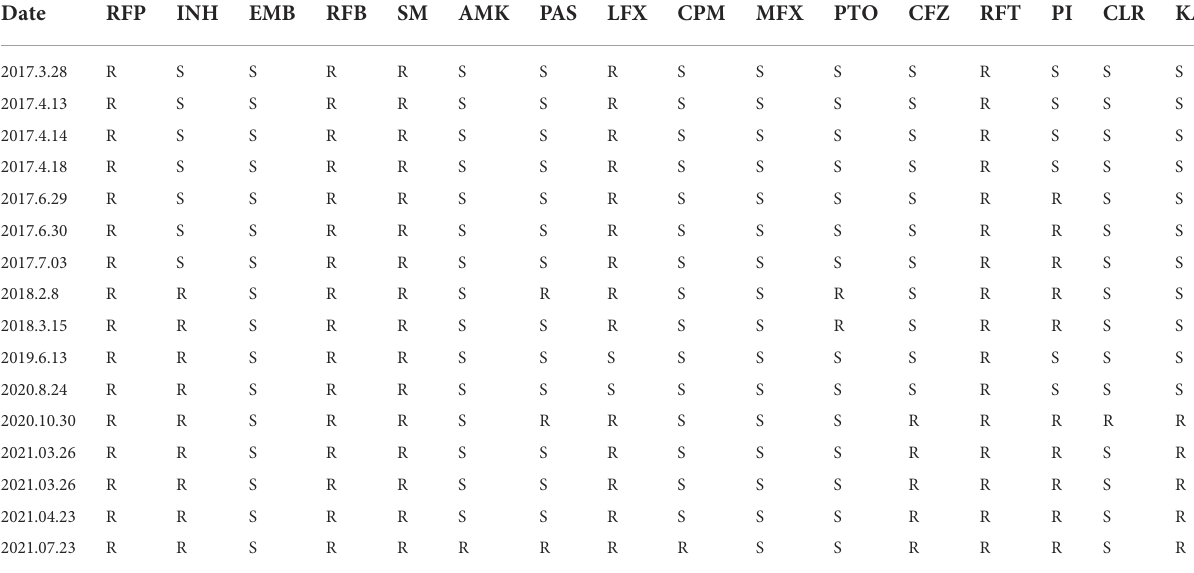
TABLE 1 The results of drug susceptibility test to 16 drugs from 2017 to